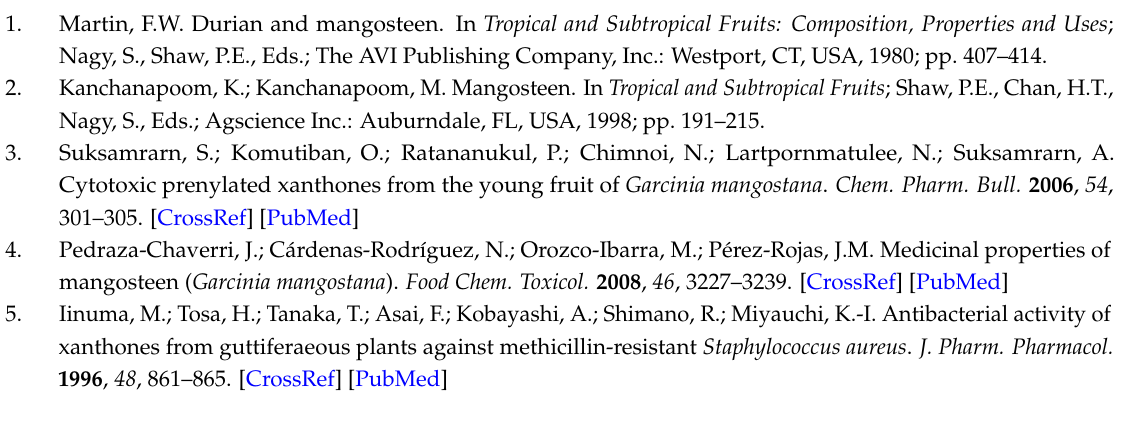
Supplementary Materials: The following are available online. Figure S1: title Molecules Narasimhan